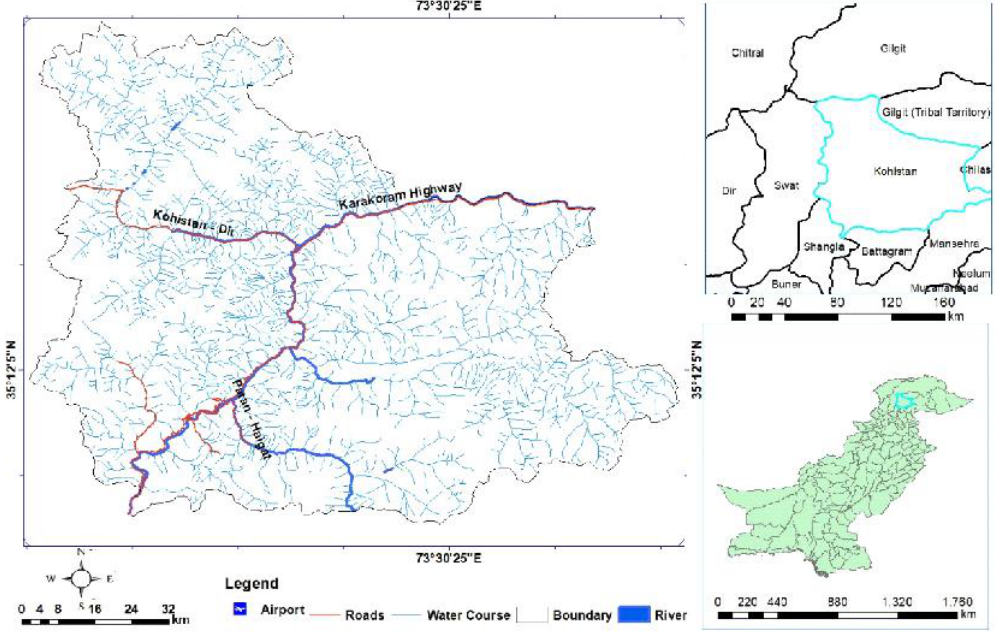
Fig. 1: Location Map of Kohistan District, Khyber Pakhtunkhwa province,